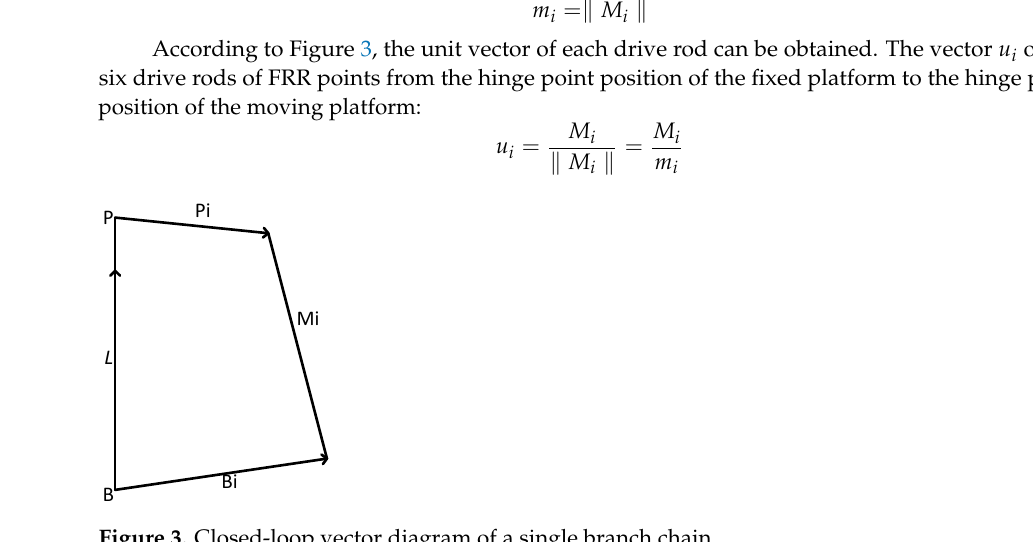
Figure 3. Closed-loop vector diagram of a single branch chain.